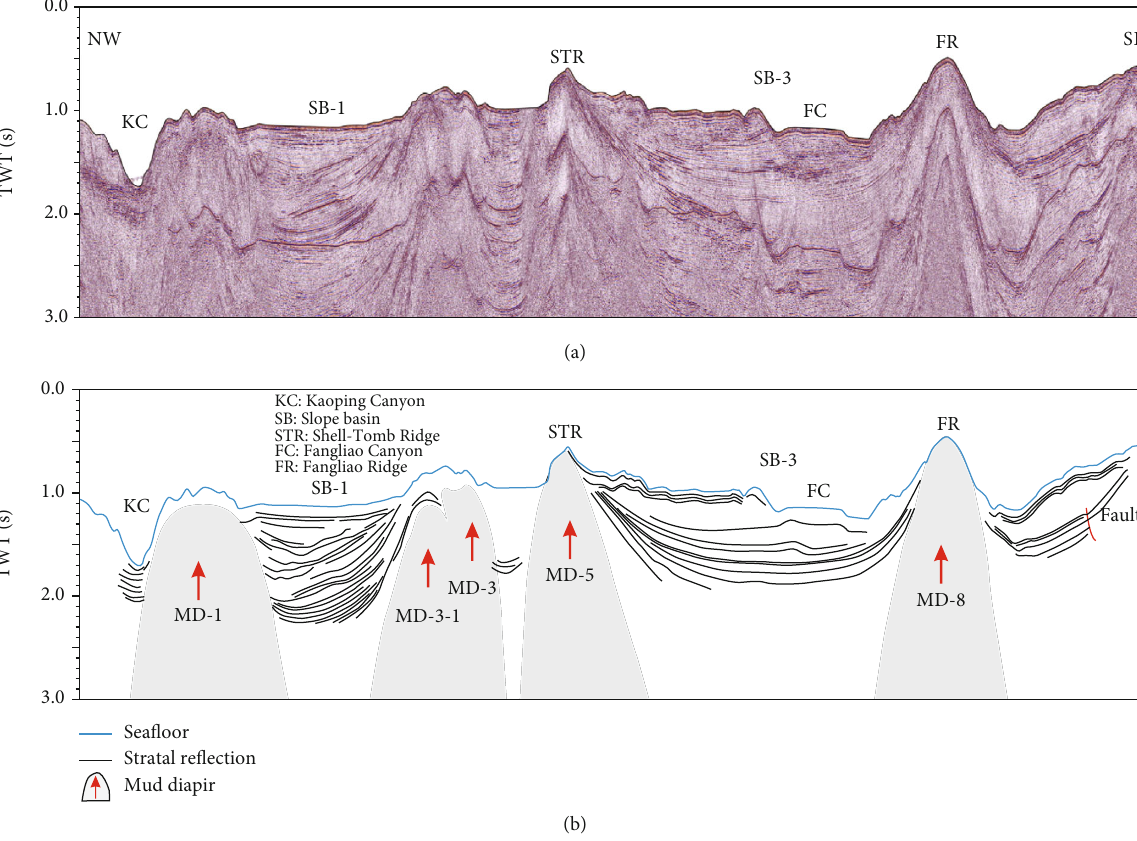
Figure 7: (a) Seismic pro fi le and (b) the interpreted seismic pro fi le over the Southwest Taiwan Basin. Five mud diapirs are present in this pro fi le, and the two on the right have pierced through thick sediments and are exposed at the sea fl oor, and the surrounding rock is uplifted, obviously (modi fi ed from